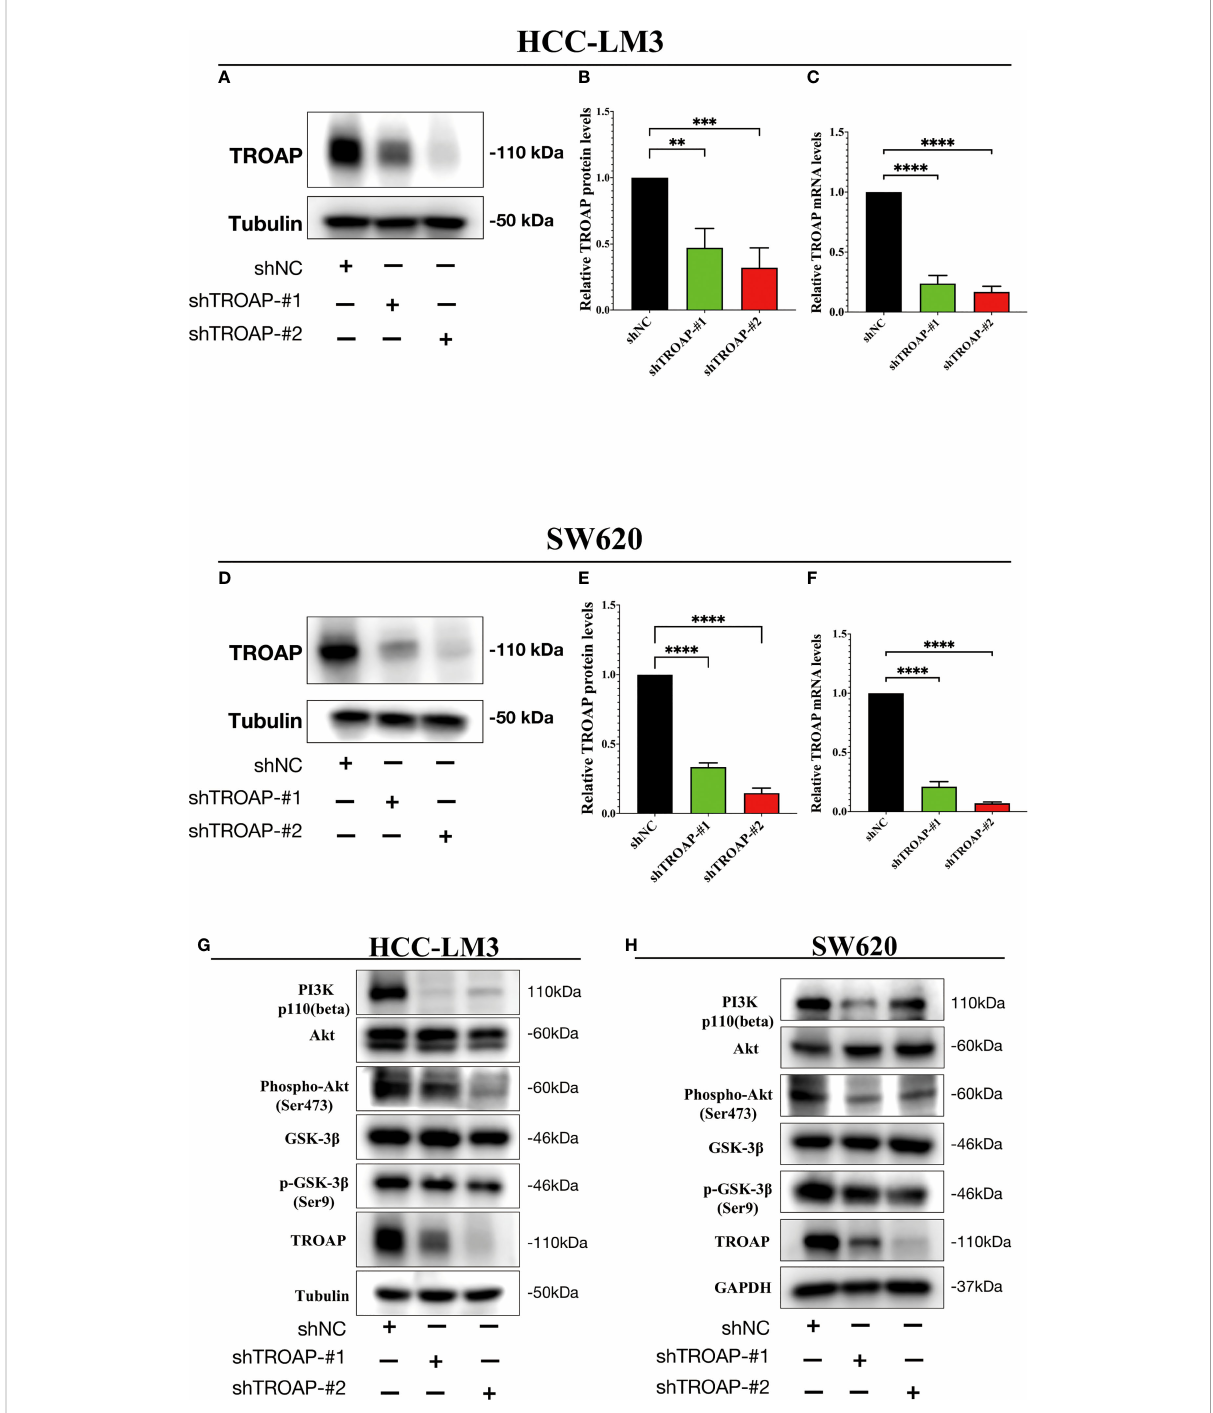
FIGURE 4 TROAP-induced malignant phenotype via activating the PI3K/Akt/GSK3 b signaling in HCC and CRC cells. (A, B, D, E) The downregulation of TROAP in HCC-LM3 (A) and SW620 (D) cells after lentivirus-mediated silence of TROAP were con fi rmed by Western blot. The statistics were shown in histograms (B , E) . (C, F) TROAP knockdown in HCC-LM3 and SW620 cells were veri fi ed by qRT-PCR. (G, H) Western blot analysis showing the expression of PI3K/Akt/GSK3 b signaling-related proteins after silencing TROAP in HCC-LM3and SW620 cells. All **:P < 0.01, ***:P < 0.001 and ****:P <